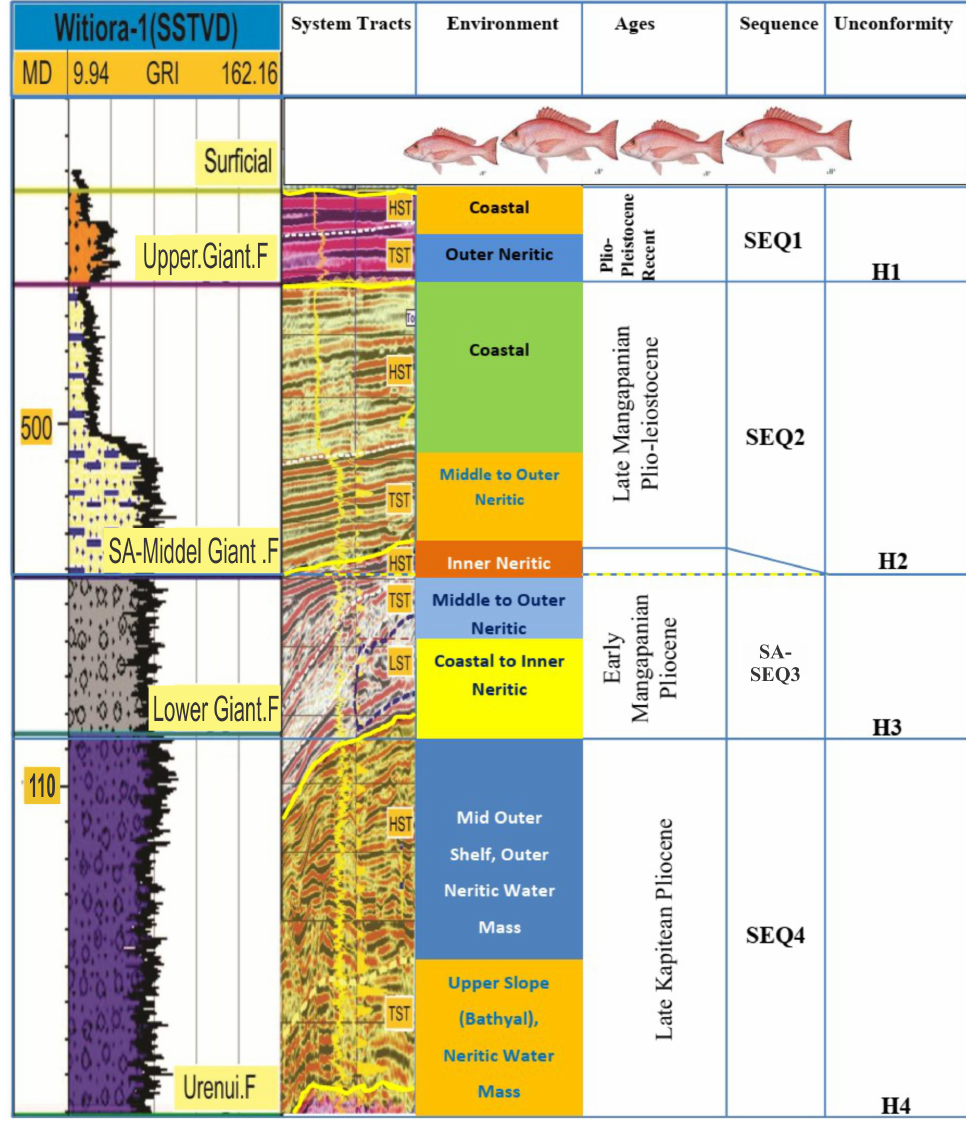
Figure 6. The chronostratigraphic charts of SEQ4 to